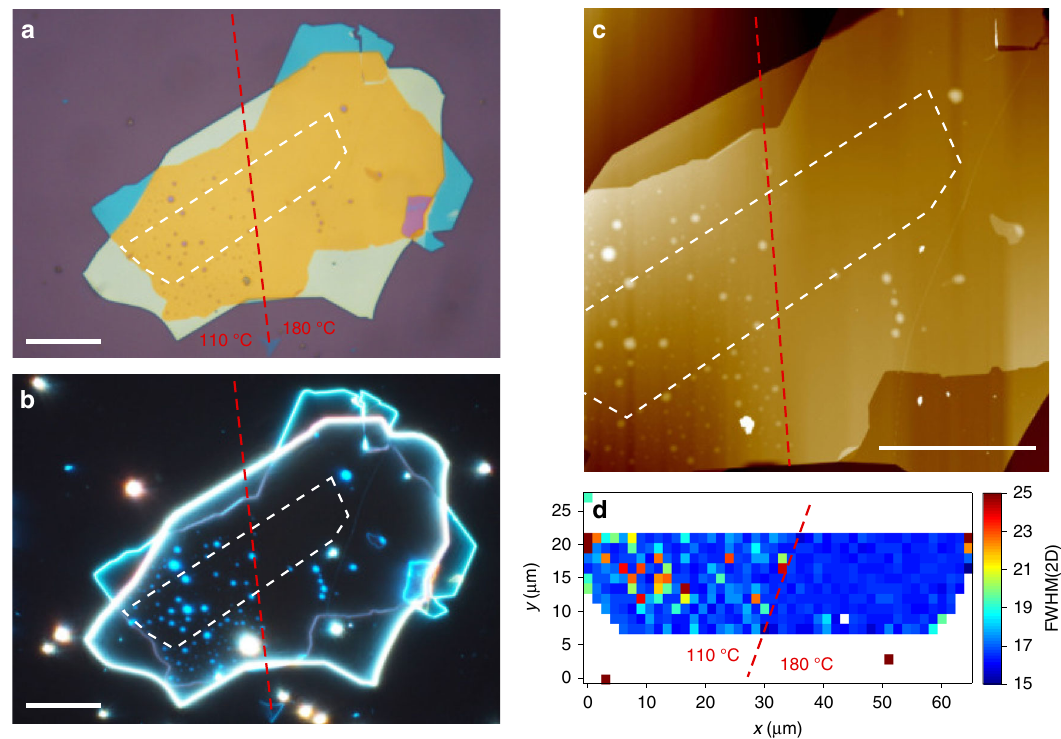
Fig. 4 Effect of the temperature on blister cleaning. a Optical image of a sample partially cleaned at 110 and 180 °C. b , c Optical dark fi eld and AFM images of the same sample. d FWHM(2D). The interface between the regions cleaned at 110 and 180 °C is marked by a dashed red line. The SLG location is marked by a while dashed line. Scale bars 20 μ